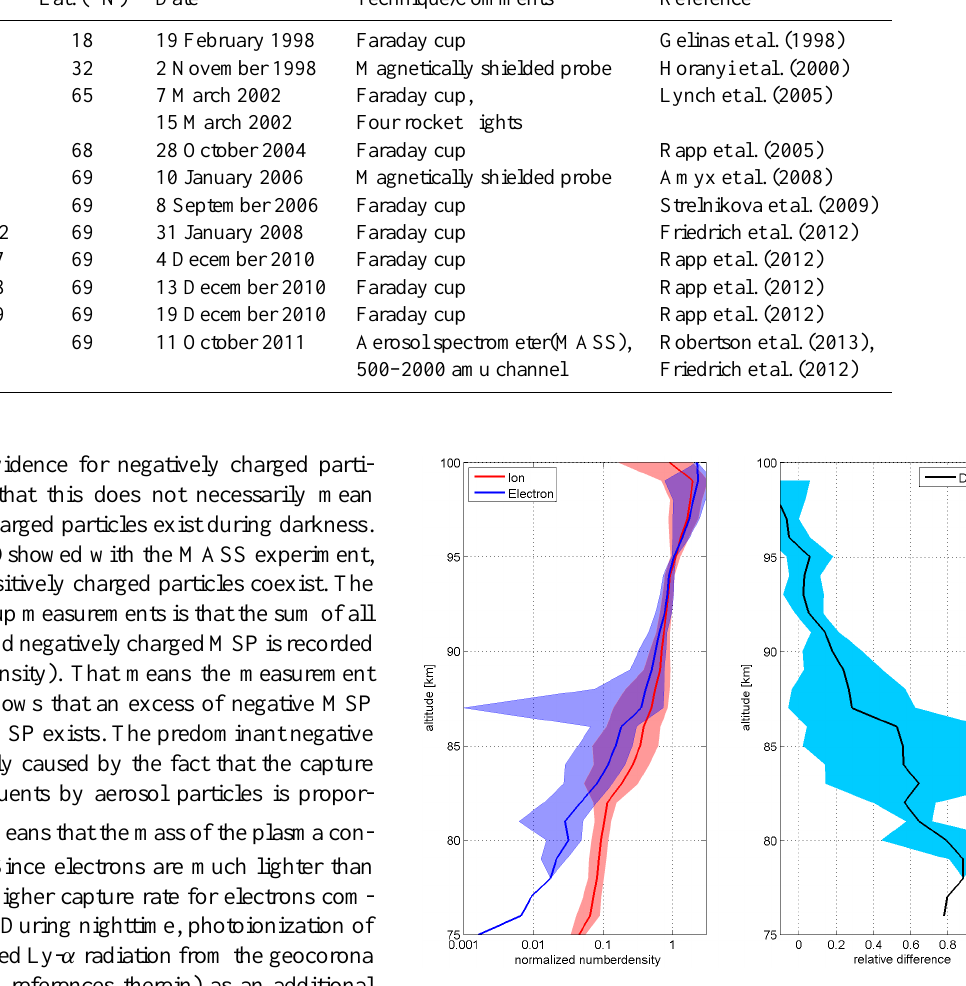
Fig. 2. Left panel: mean normalized electron density (black) and positive ion density (red) profiles from in situ measurements of Friedrich et al. (2012) with the corresponding standard deviation, the electron density at 95km for each rocket flight has been used for normalization of electron and ion density. The standard devia- tion of the normalized electron densities exceeds the mean value at 88 km. Right panel: relative difference between electron and posi- tive ion